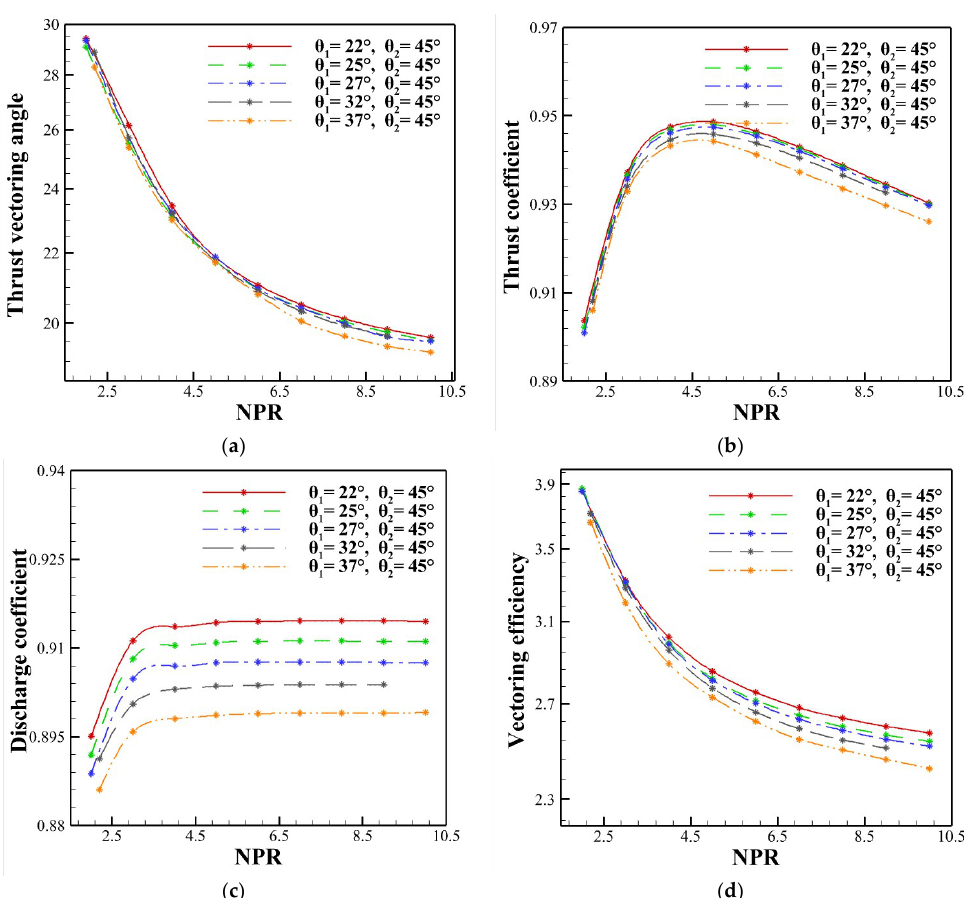
Figure 11. Plotting of ( a ) vectoring angle, ( b ) thrust coefficient, ( c ) discharge coefficient, and ( d ) vectoring efficiency for h b /h t = 0.185.